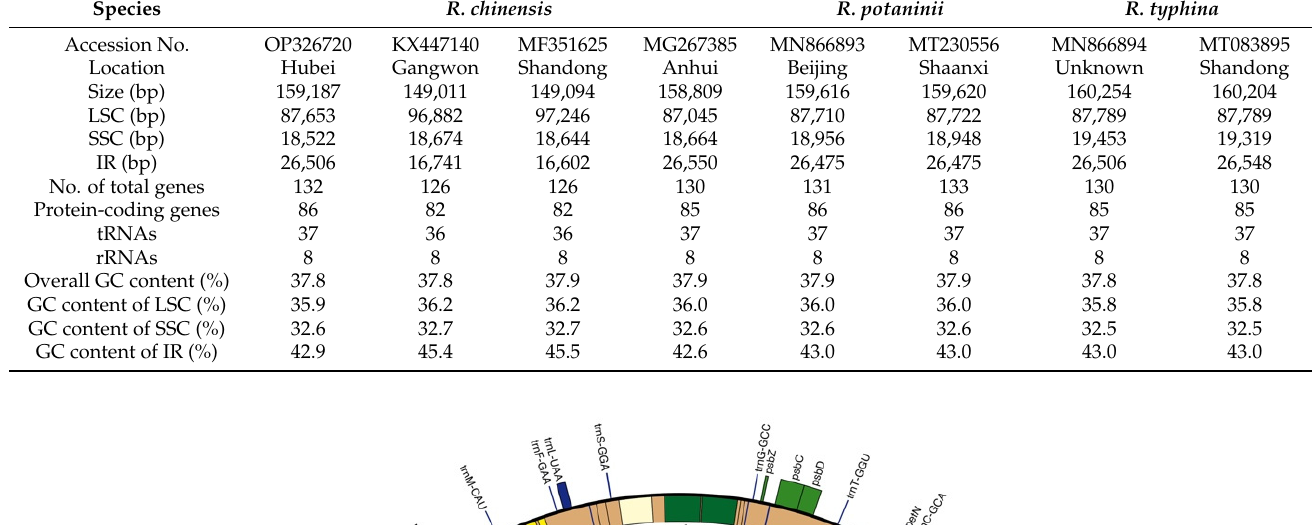
Table 2. Characteristics of the complete chloroplast genomes of Rhus species.